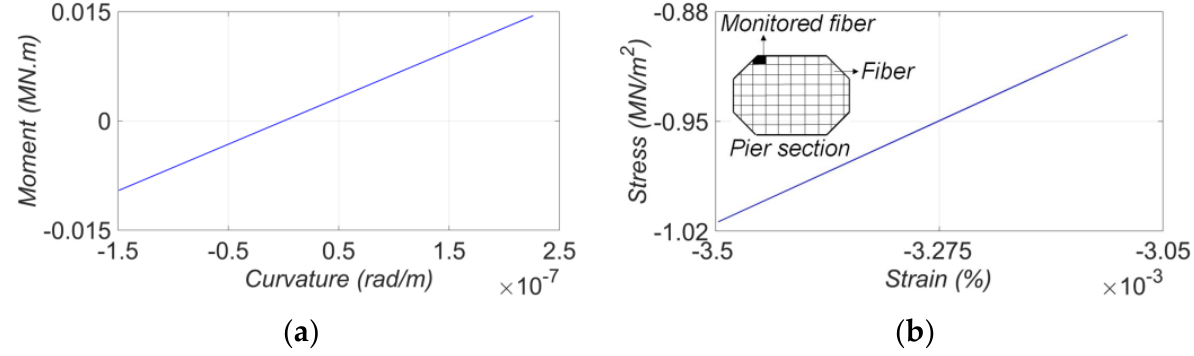
Figure 22. Local level response monitored in SRC bridge using its digital twin during 2013 IslaVista earthquake event: ( a ) moment-curvature response (about the transverse direction) at the lowest section of the east pier, and ( b ) estimated stress-strain response in the extreme fiber at the lowest section of the west pier.